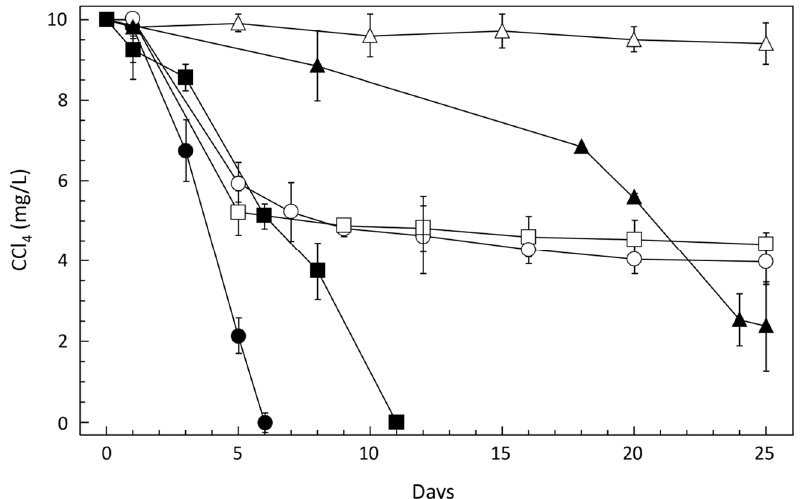
Figure 1. CCl 4 degradation by enrichment cultures from the contaminated aquifer. Enrichments C1 (filled circles) and C2 (filled squares) were grown in C medium, and enrichments C3 (filled triangles); C4 (open squares); C5 (open circles) and a non-dechlorinating control consortium (open triangles) in MBM medium (see Materials and Methods and Tables S1–S2 for details). Error bars represent the standard error of 3 technical